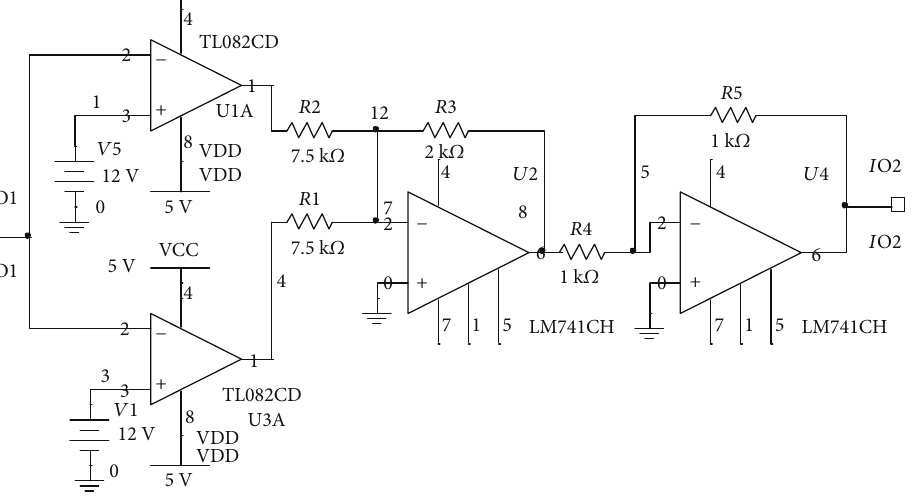
Figure 13: Step function